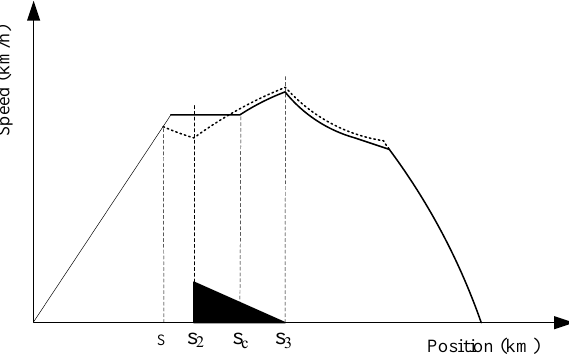
Figure 6. Driving strategies with coasting from s and s c ,